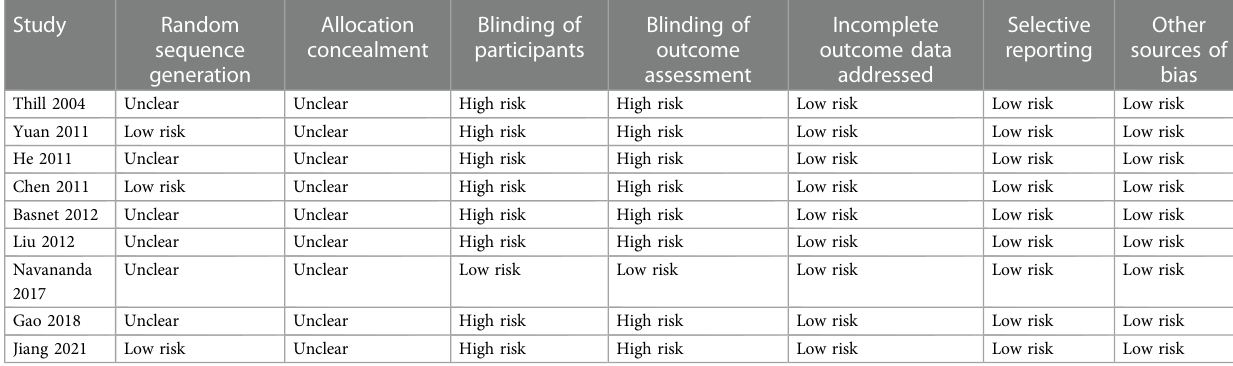
TABLE 3 Study quality evaluation via cochrane ’ s risk of bias